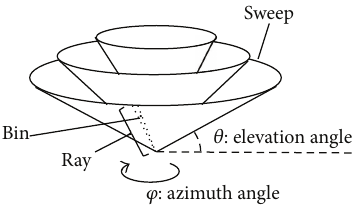
Figure 2: Principle of radar data observation.